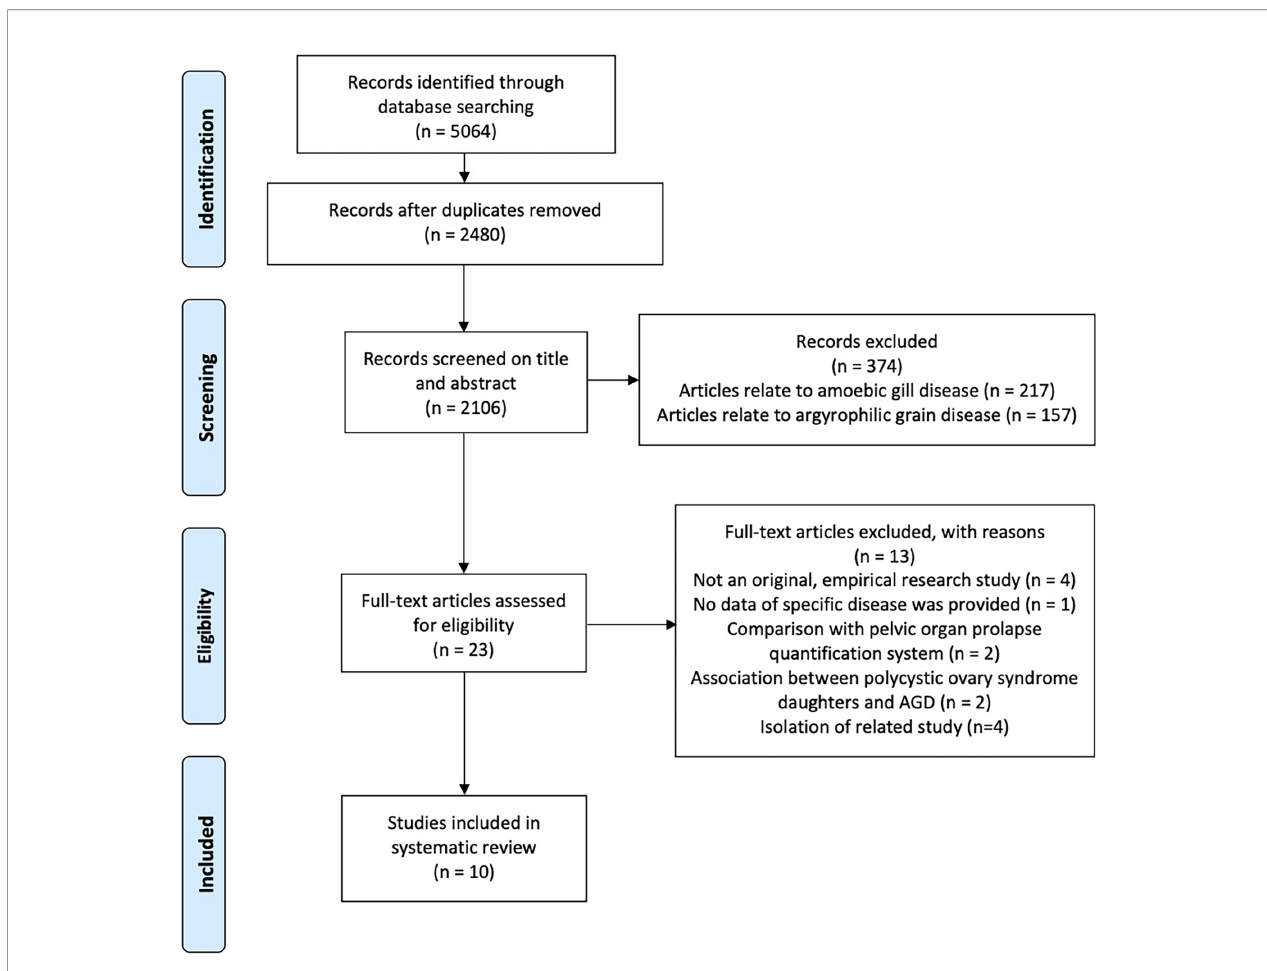
FIGURE 1 | PRISMA 2009 fl ow